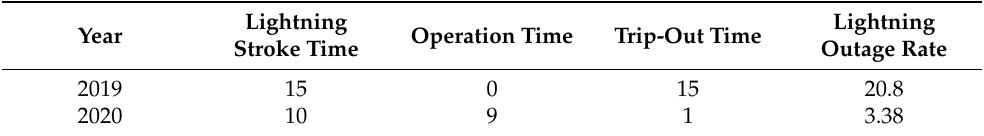
Table 2. Actual operational record data of the